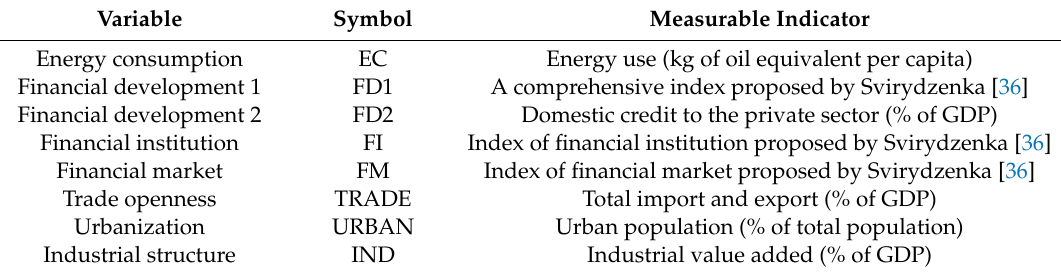
Table 2. Variable descriptions.